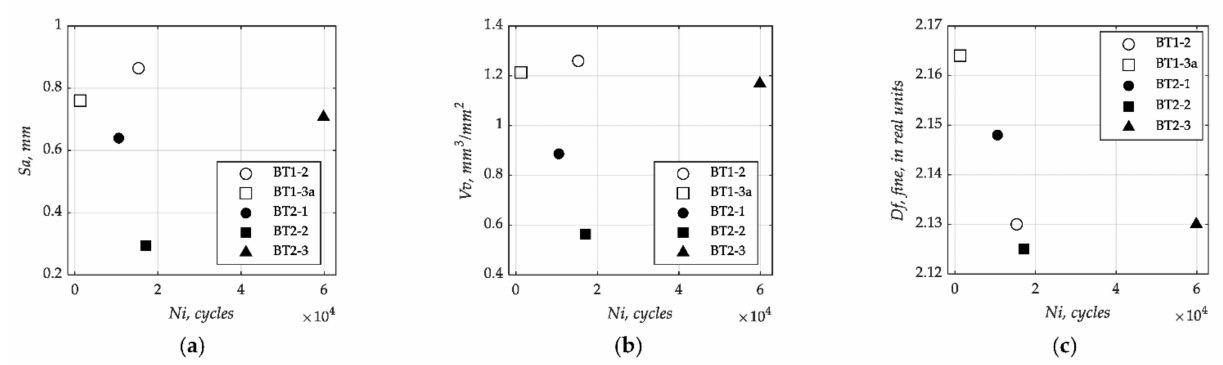
Figure 10. ( a ) Arithmetical mean height Sa parameter against the number of cycles to fatigue crack initiation N i ; ( b ) void volume Vv parameter against the number of cycles to fatigue crack initiation N i ; and ( c ) fractal dimension Df against the number of cycles to fatigue crack initiation N i .